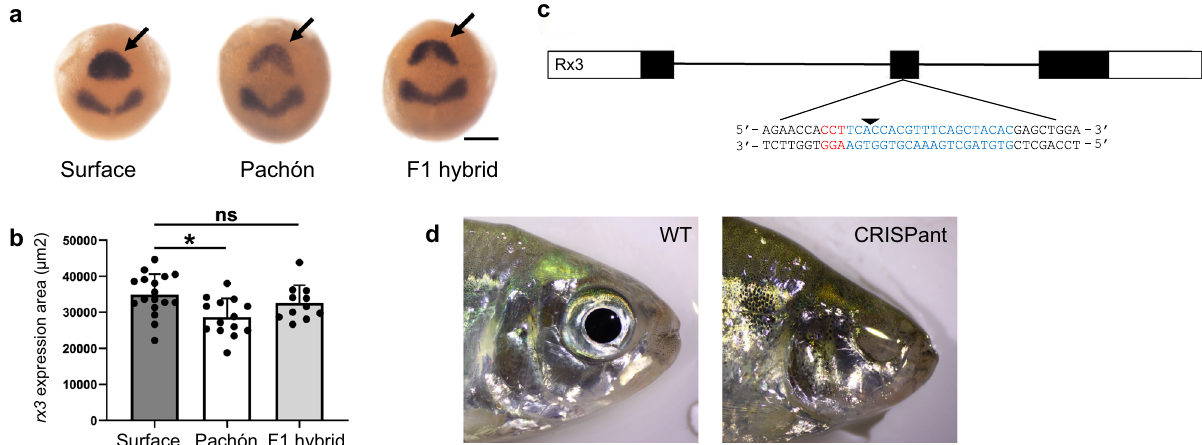
Fig. 2 Rx3 analysis. a Photographs of in situ hybridizations for rx3 (arrows) and pax2 mRNA at tailbud stage on surface fi sh, Pachón cave fi sh, and F1 hybrid between surface fi sh male and Pachón cave fi sh female. Scale bar: 200 µ m. b Comparison of expression area of rx3 at tailbud stage on surface fi sh (mean value 34876.3 µ m 2 , SD ± 5767.2, n = 17), Pachón (mean value 28674.8 µ m 2 , SD ± 5175.0, n = 14), and F1 hybrid (mean value 32617.8 µ m 2 , SD ± 4917.2, n = 11). Signi fi cance is shown for unpaired Student ’ s t test (two-tailed); p = 0.004 is denoted by * and ns means not signi fi cant ( p = 0.294). c Diagram of rx3 gene. Boxes indicate exon and lines indicate introns. The empty boxes are UTR and the fi lled boxes are coding sequence (gene build from NCBI). A gRNA was designed targeting exon 2. The gRNA target site is in blue and the PAM site is in red. The arrow indicates the predicted Cas9 cut site. d